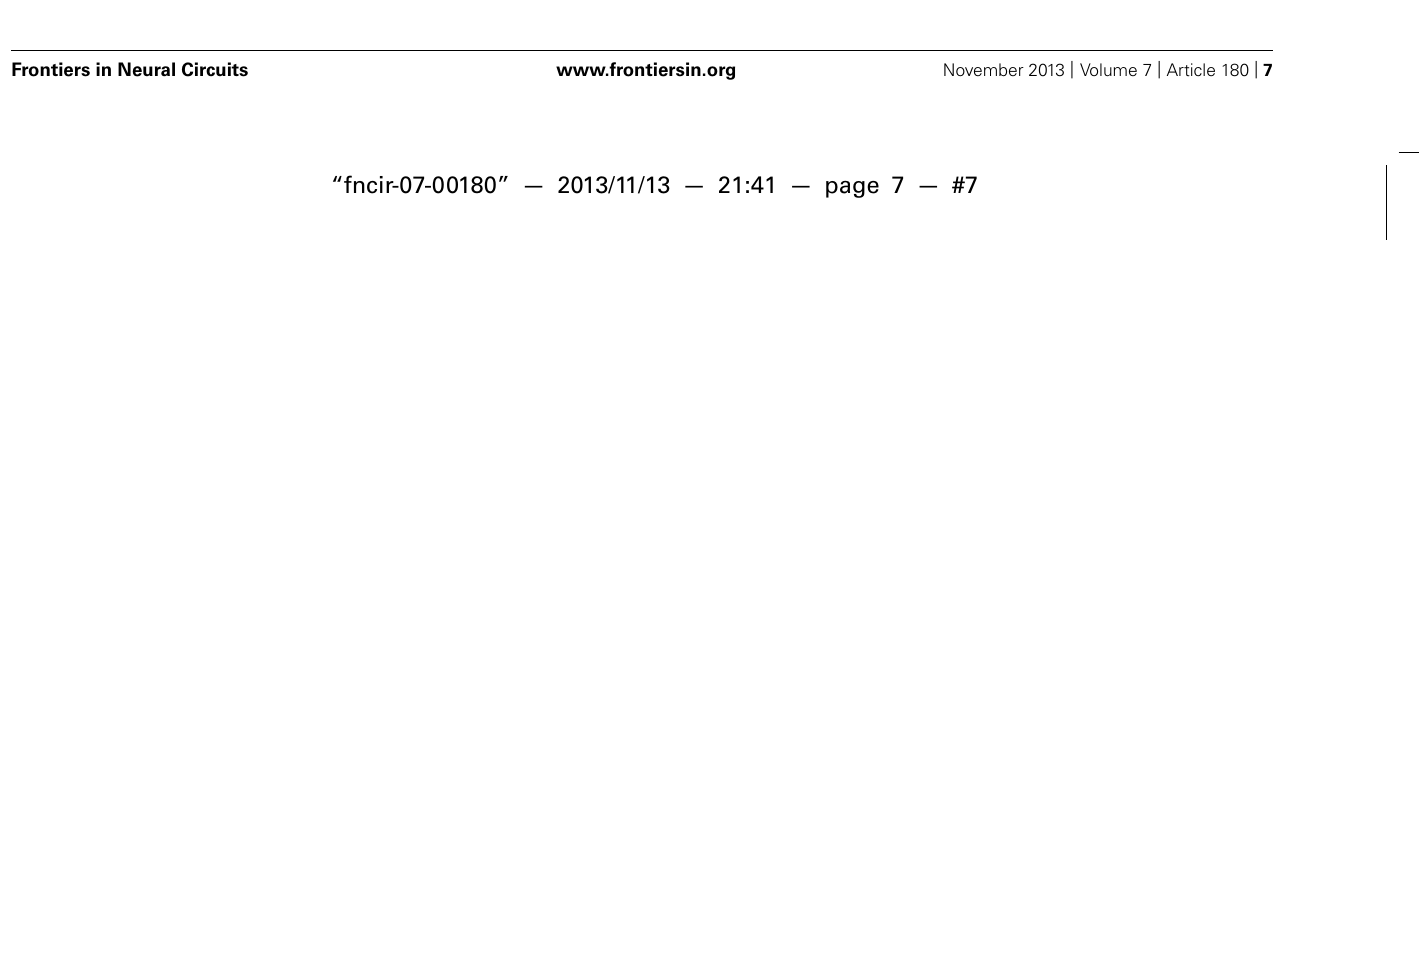
after the injection. Neurons visualized with fluorescent Nissl stains (Neurotrace; green). The injected Cbln1 was localized to the cerebellar cortex. Asterisks in the enlarged images indicate the deep cerebellar nucleus (DCN). Scale bars, 20 μ m. (D) Cbln1 transiently rescued the impaired delay EBC in cbln1 − / − mice. The CR% increased significantly in cbln1 − / − mice trained 2 days after a Cbln1 injection [ + Cbln1 (2d)] compared to those trained 30 days after [ + Cbln1 (30 days)] the injection or those not treated with Cbln1 (no inj; p < 0.01, a two-way repeated measures ANOVA, n = 8 for each group). T1 − T7, training sessions; Sp1 and Sp2, spontaneous eyeblink responses before training. The dotted line corresponds to the average percentage of CR-like activities on Sp2 to indicate the baseline for learned